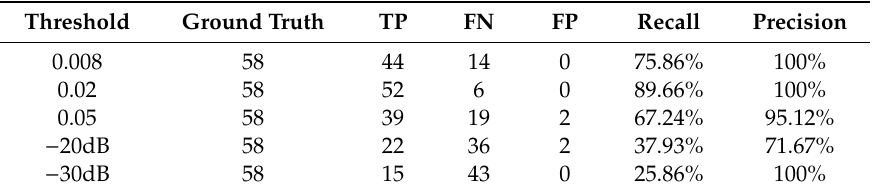
Table 7. Quantitative results of ship detection in the TerraSAR-X test images. Where TP indicates the number of correctly detected ships; FN denotes the number of non-detected or missed ships; and FP represents the number of incorrectly detected